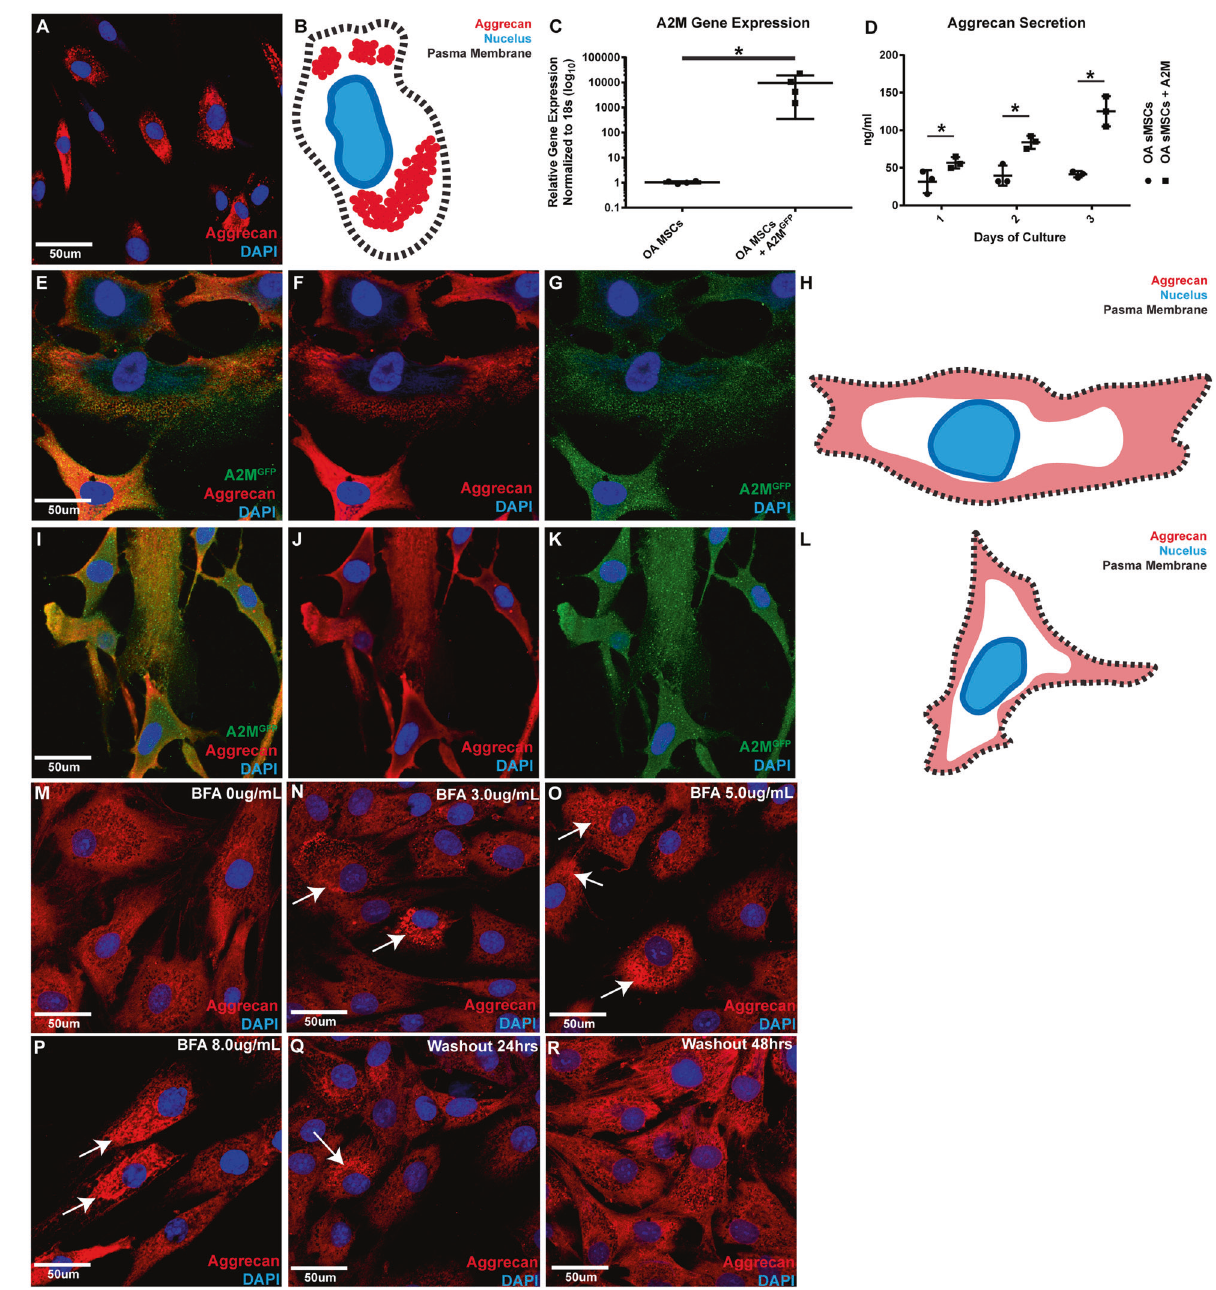
Fig. 7 Overexpression of A2M alters aggrecan staining pattern and increase secretion in OA synovial MPCs. Un-transfected OA synovial MPCs demonstrating intense, punctate, perinuclear aggrecan staining pattern adjacent to the nucleus as observed previously ( A diagrammatic representation B ). OA MPCs also demonstrated low expression levels of A2M, and this could be rescued through A2M overexpression ( C ). In OA MPCs, A2M overexpression increased the secretion of aggrecan during all time-points examined when compared to the un-transfected parental cell lines ( D ). With A2M overexpression in OA MPCs (two patient cell lines shown as representative examples: E , I ), aggrecan staining was no longer observed adjacent to the nucleus ( F , J diagrammatic representation H , L ). Instead A2M expression (GFP) was observed throughout the cytoplasm of the transfected cells ( G , K ). BFA treated of A2M transfected MPCs results in a redistribution of aggrecan within the cells directly related to the BFA concentration ( M – P ). This phenotype can be reversed by removing the BFA ( Q , R ). Scale bars equal 50 µm. * p < enriches for a multipotent progenitor subpopulation [37, 39] and recognized by CD90 in the synovium (endothelia cells, neural cell we found that both normal and OA CD90-positive human synovial types and potentially myo fi broblasts) [38] or that not every MPCs expressed aggrecan in vitro. Aggrecan expression has synovial MPC expresses aggrecan in vivo. While it is known that previously been reported in bone marrow MSCs [13], suggesting CD90 alone is not suf fi cient to identify MPCs, it has been that aggrecan may play a role in MPCs within the undifferentiated demonstrated that CD90 (in human and rat, among others)